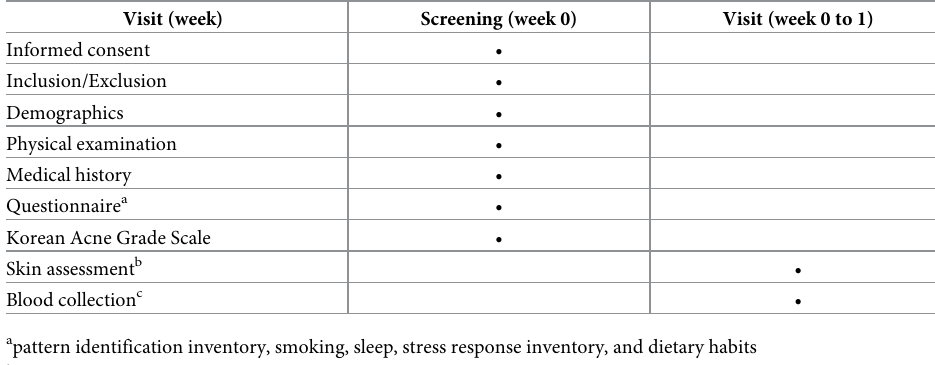
Table 1. Study schedule.